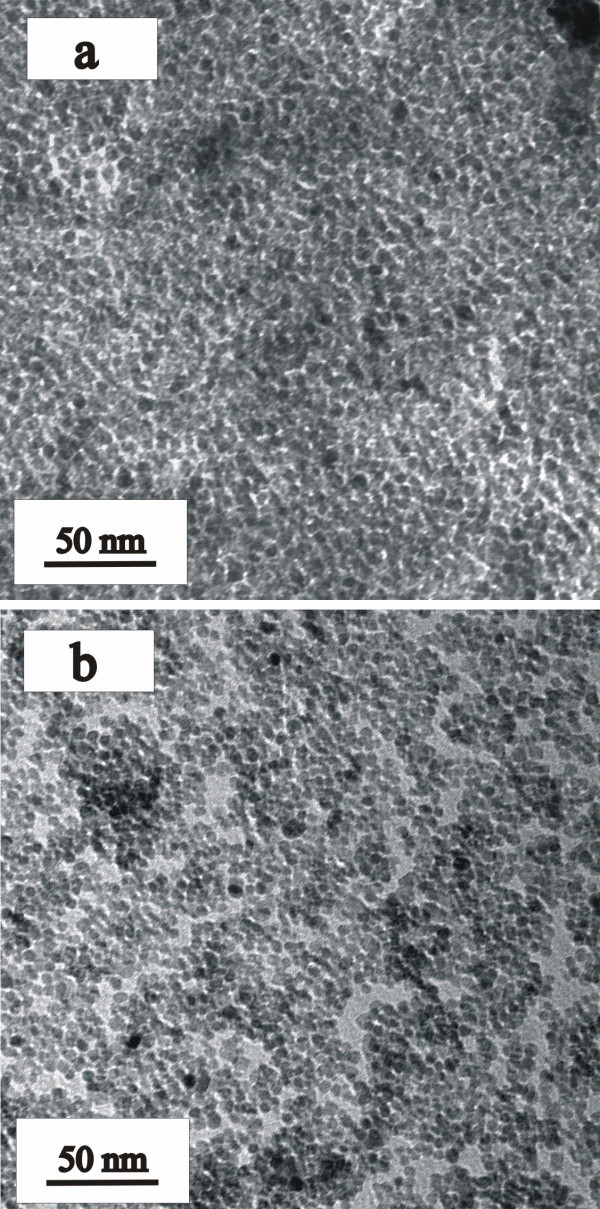
TEM images of (a) SA-coated and (b) Asp-coated TiO2 nanoparticles.